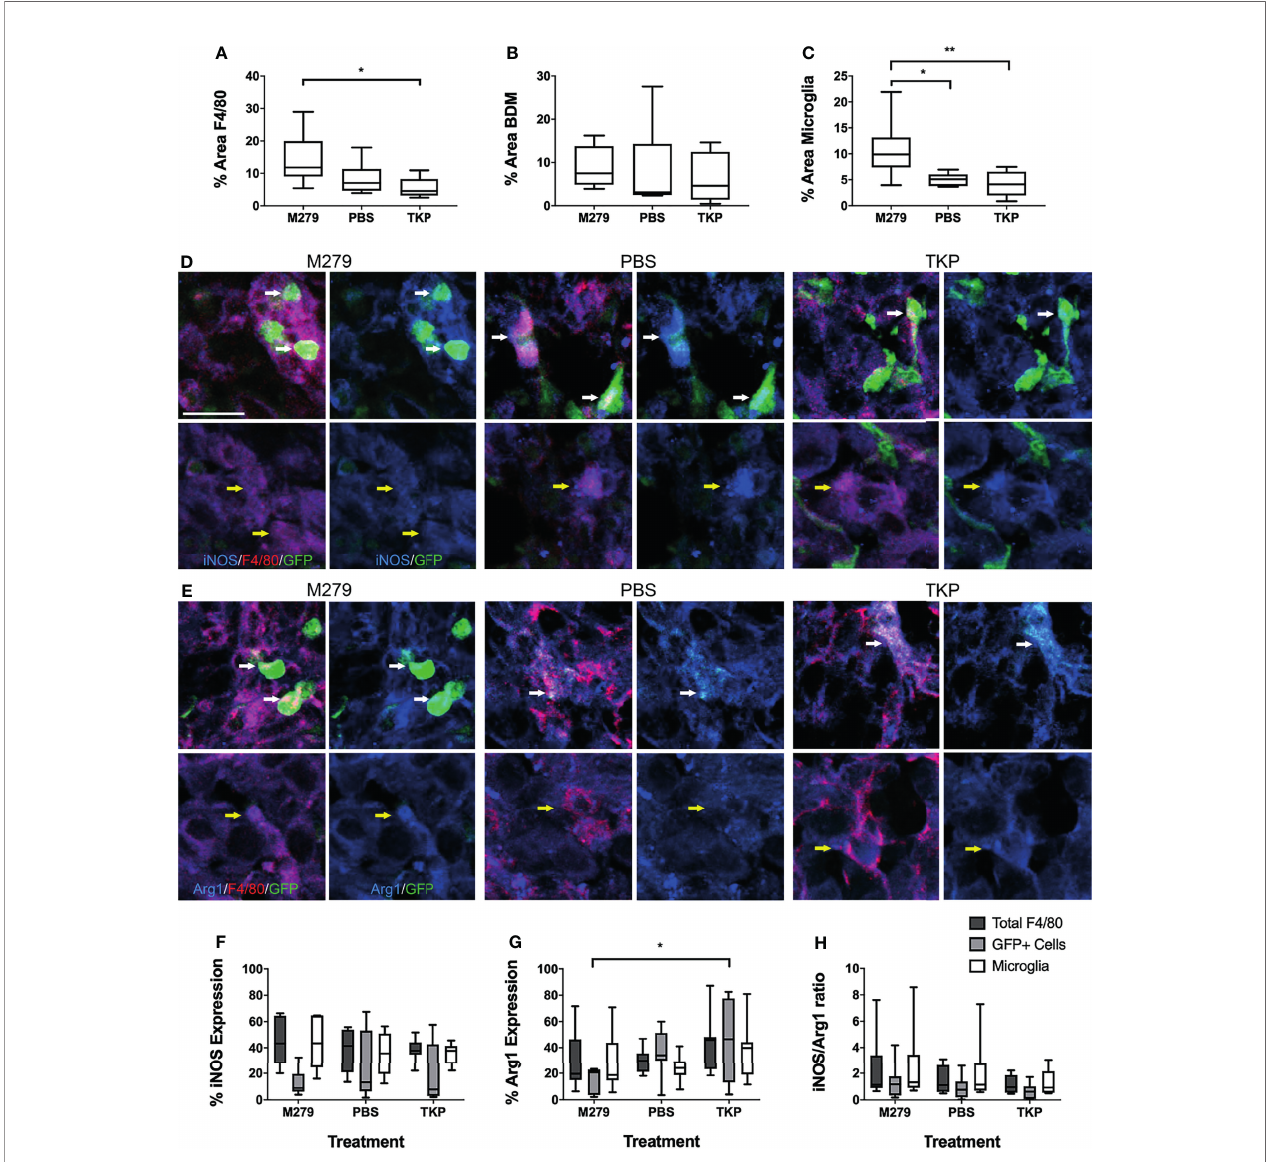
FIGURE 4 | Effect of phenotype modulation of microglia and blood-derived macrophages (BDM) with TKP and the CSF-1R neutralizing antibody, M279. (A – C) Graphs showing percentage of tumour area that is stained for (A) all F4/80+ cells, (B) GFP+ BDM and (C) GFP- microglia. (D, E) Immuno fl uorescent staining of F4/ 80 (red) with (D) iNOS or (E) Arg1 (blue) and endogenous GFP in M279 (n = 7), PBS (n = 7) and TKP (n = 8) treated mice. In each panel, the upper rows are highlighting GFP+ BDM (white arrows), whilst the lower rows are highlighting GFP- microglia (yellow arrows). (F – H) Graphs showing expression of (E) iNOS, (F) Arg1 and (G) ratio of iNOS : Arg1 expression in all F4/80+ cells (dark grey bars), GFP+ BDM (light grey bars) and microglia (white bars). Data shown as box and whisker plots depicting full range of data points. Scale bar = 20 µm. *p <